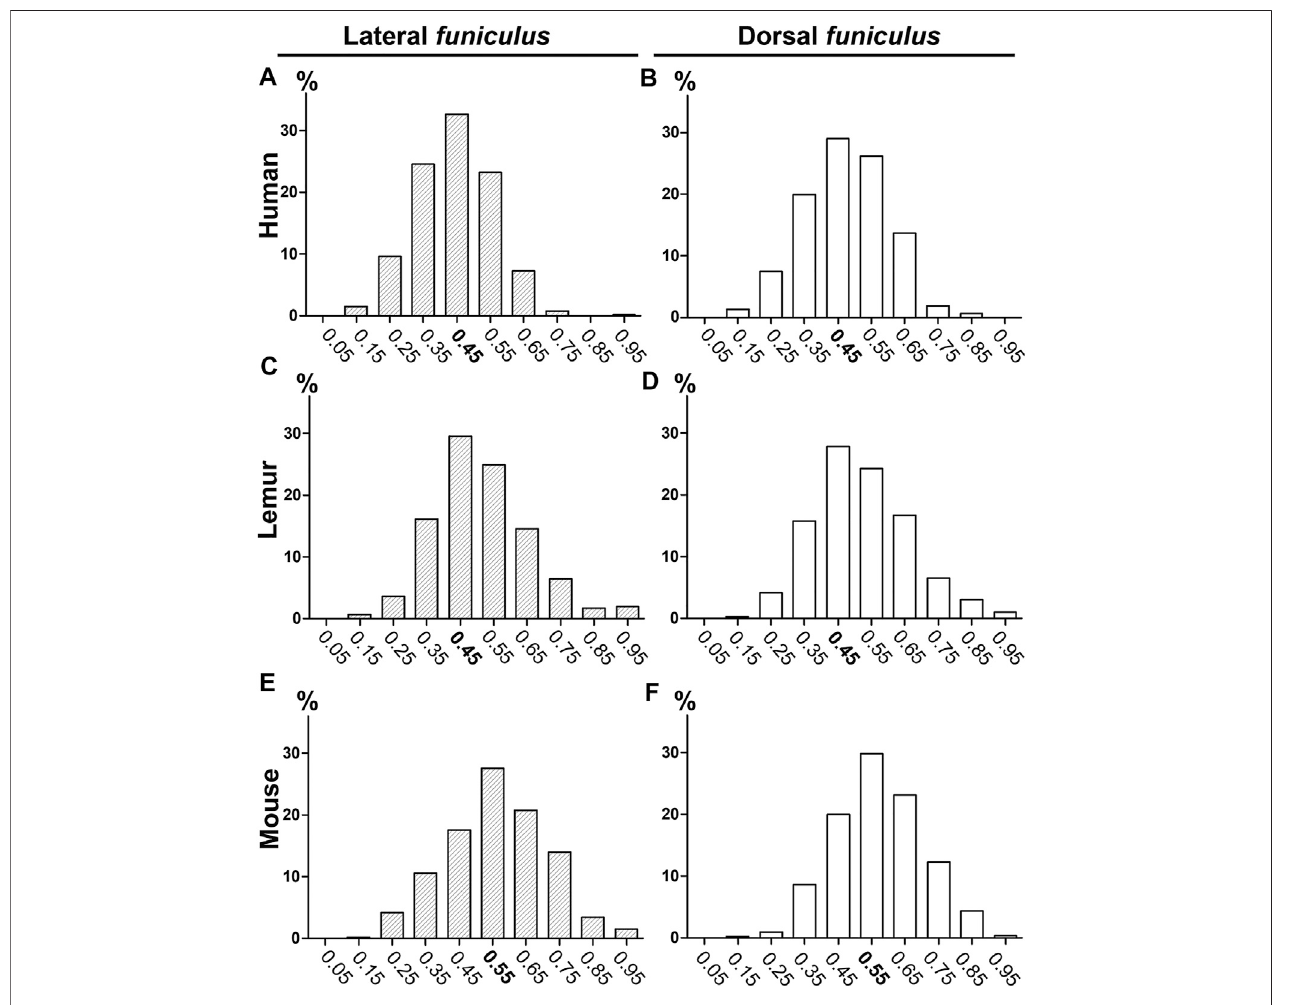
FIGURE 2 | Histograms of g-ratio distribution in humans, lemurs, and mice using CARS microscopy . Distributions of g-ratio in lateral (A , C , E) and dorsal ( B, D , F ) funiculi were quanti fi ed in humans (A – B) , lemurs (C – D), and mice (E – F) . The number of fi bers analyzed: n is at least 432 and up to 681 per group.